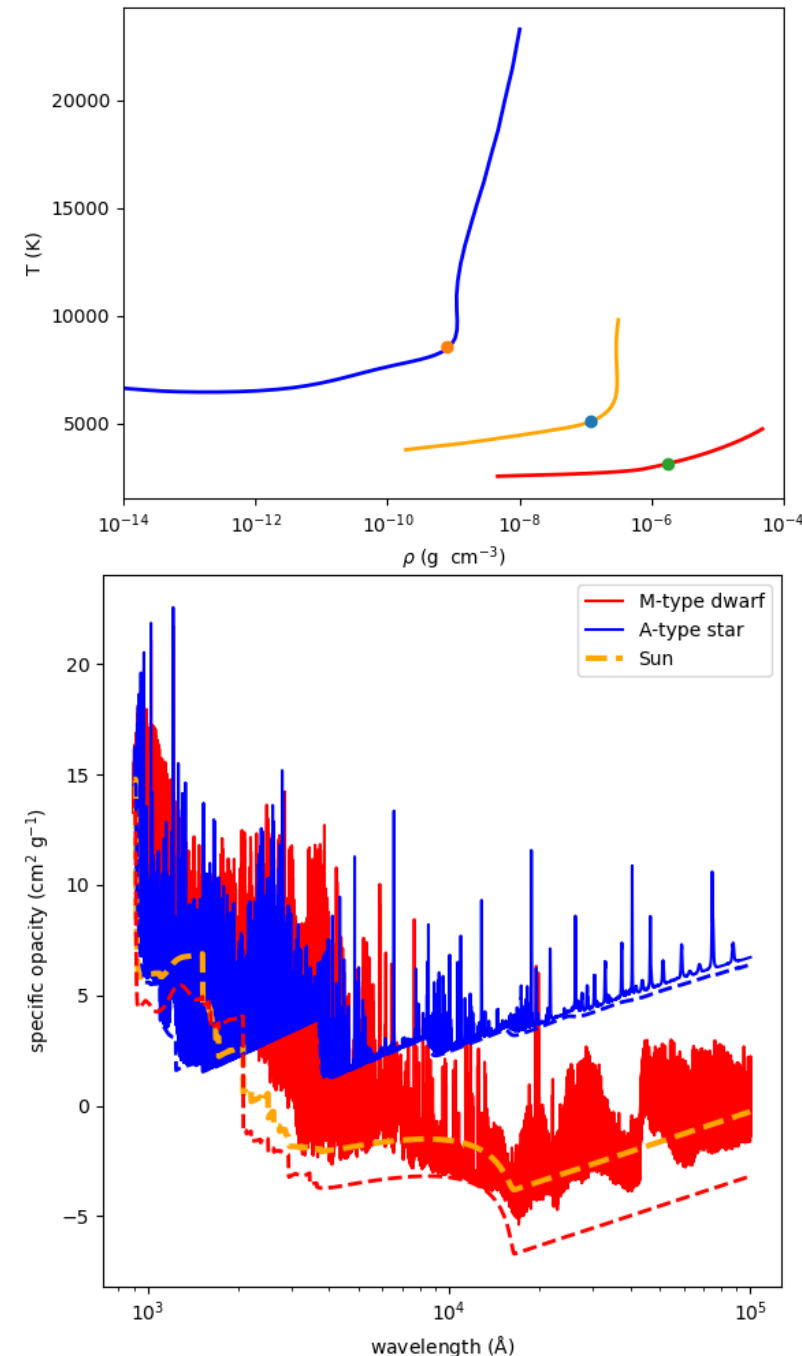
Figure 3. Similar to Figure 1 for the main sequence M-type ( T eff = 3500 K) and A-type stars ( T eff = 9800). The continuum opacity is shown with dashed lines. The total (including lines) opacity is omitted for the solar case since it is already shown in Figure 1. The representative data correspond to ( ρ (cid:39) 0.8 × 10 − 9 g cm − 3 , T (cid:39) 8600 K) in the case of the A-type star and ( ρ (cid:39) 1.8 × 10 − 6 g cm − 3 , T (cid:39) 3200 K) for the M-type